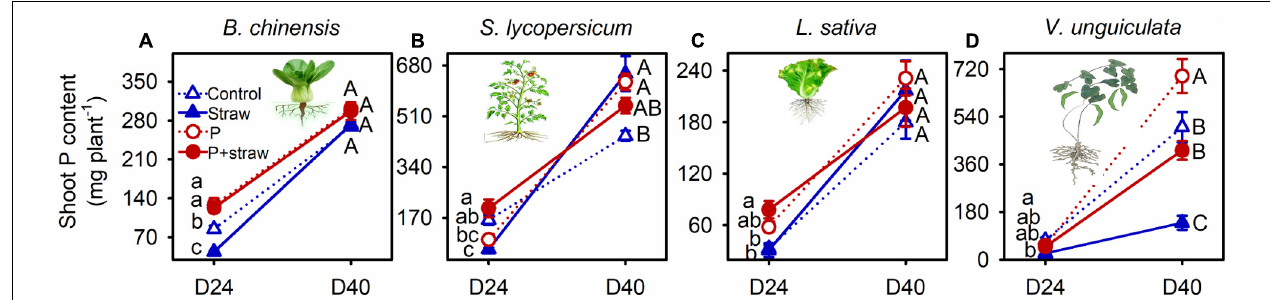
FIGURE 1 | Effects of straw addition and P fertilization on shoot P content in B. chinensis (A) , S. lycopersicum (B) , L. sativa (C) , and V. unguiculata (D) at days 24 and 40. Control: no fertilizer P or straw; straw: no P but with straw addition; P: fertilizer P at 100 mg P kg − 1 soil; P + straw: fertilizer P at 100 mg P kg − 1 soil together with straw addition. D24: 24 days after straw addition, and D40: 40 days after straw addition. Data are means ± SE ( n = 4). For each crop species, the lowercase letters denote significant differences ( p ≤ 0.05) among treatments without P or straw, with straw but no fertilizer P, with fertilizer P but no straw, and with fertilizer P and straw at day 24, and the capital letters denote significant differences ( p ≤ 0.05) among the four treatments at day 40. Significant difference (p ≤ 0.001) in shoot P content of the four crops between days 24 and 40 was detected using Student’s t -tests (see Supplementary Table 3 ).